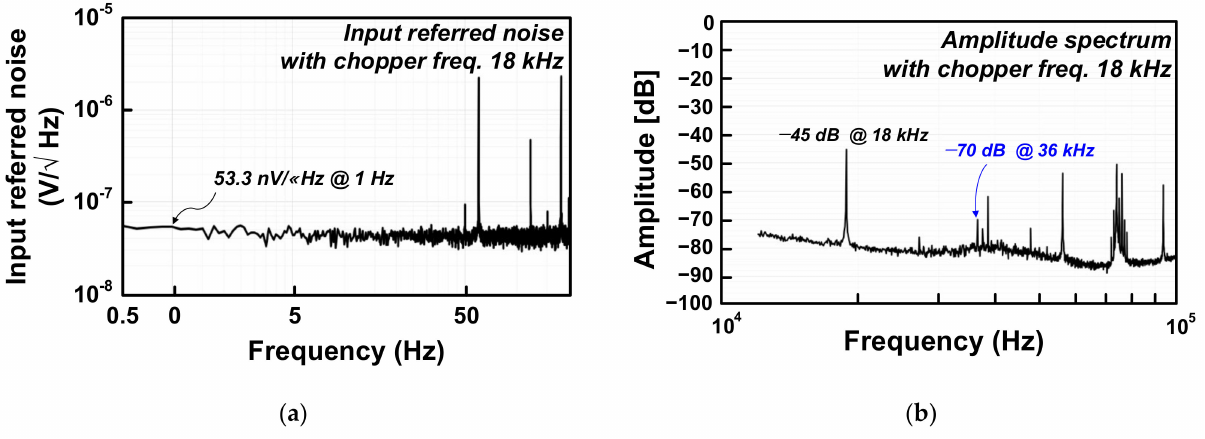
Figure 16. ( a ) Transfer function and ( b ) CMRR of the proposed CFIA.